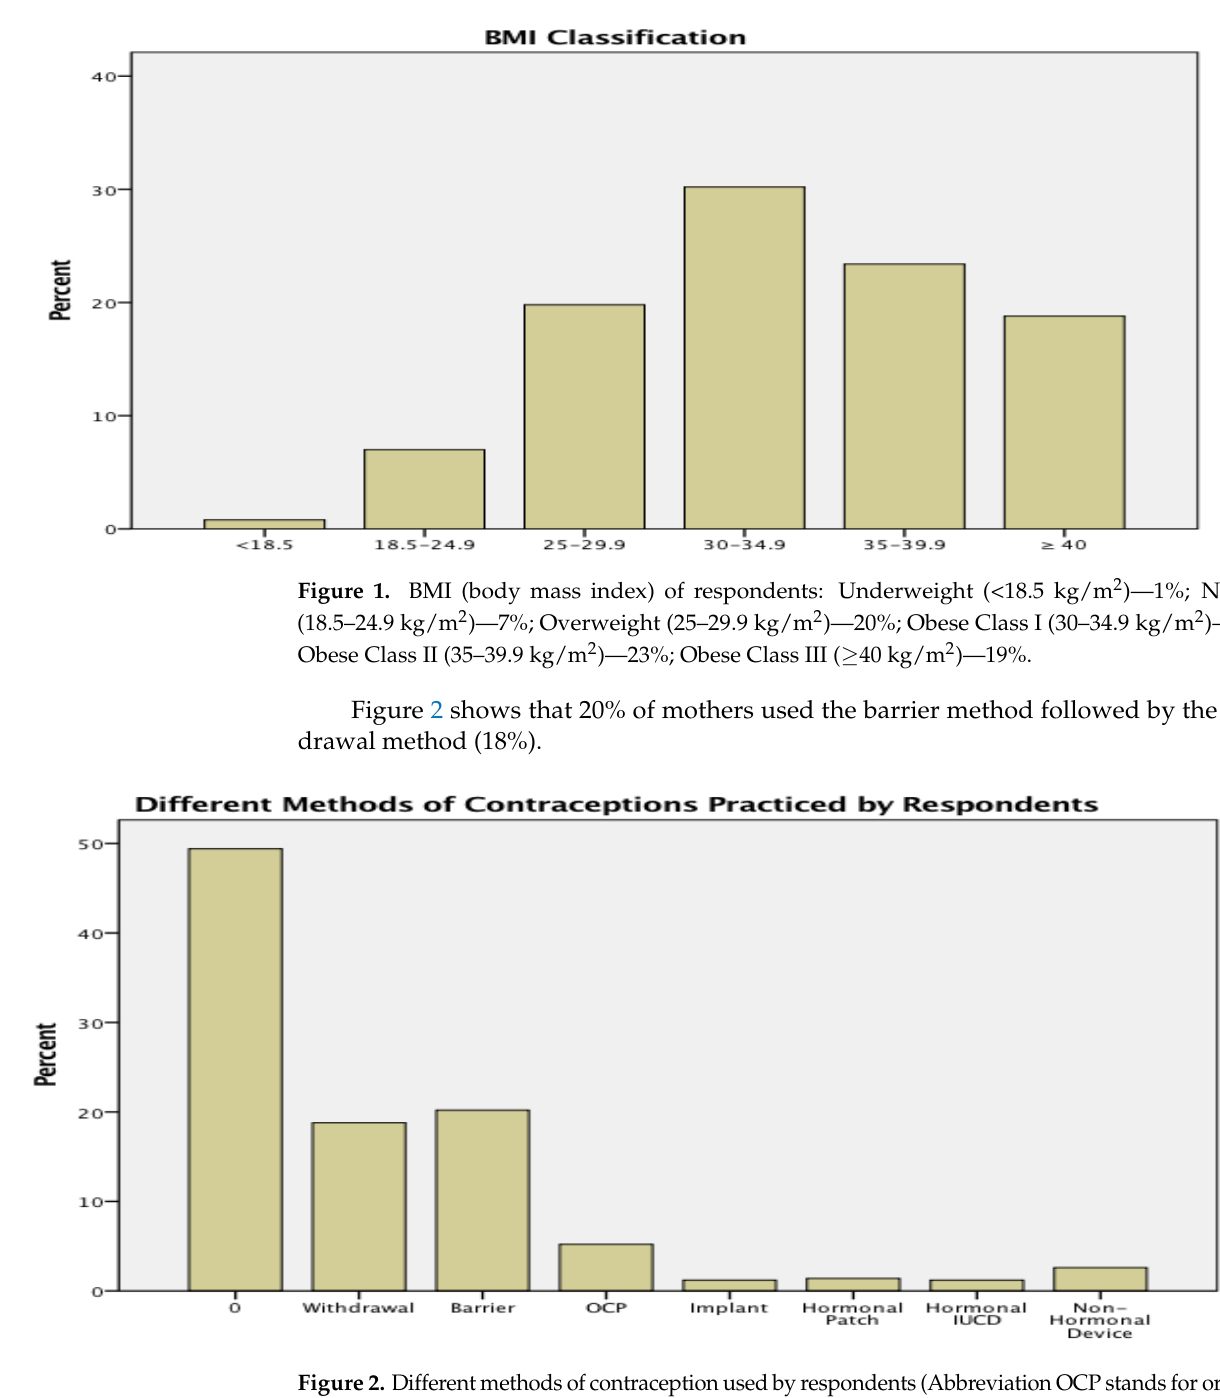
Figure 3. Reasons listed by respondents of not using any sort of contraception (Abbreviation 0 stands for contraceptive users). Table 2. Association between women of low parity and high parity with respect to fetal complica- tions (application of Chi-Square test keeping the level of significance ≤ 0.05 ). Comparing Variable